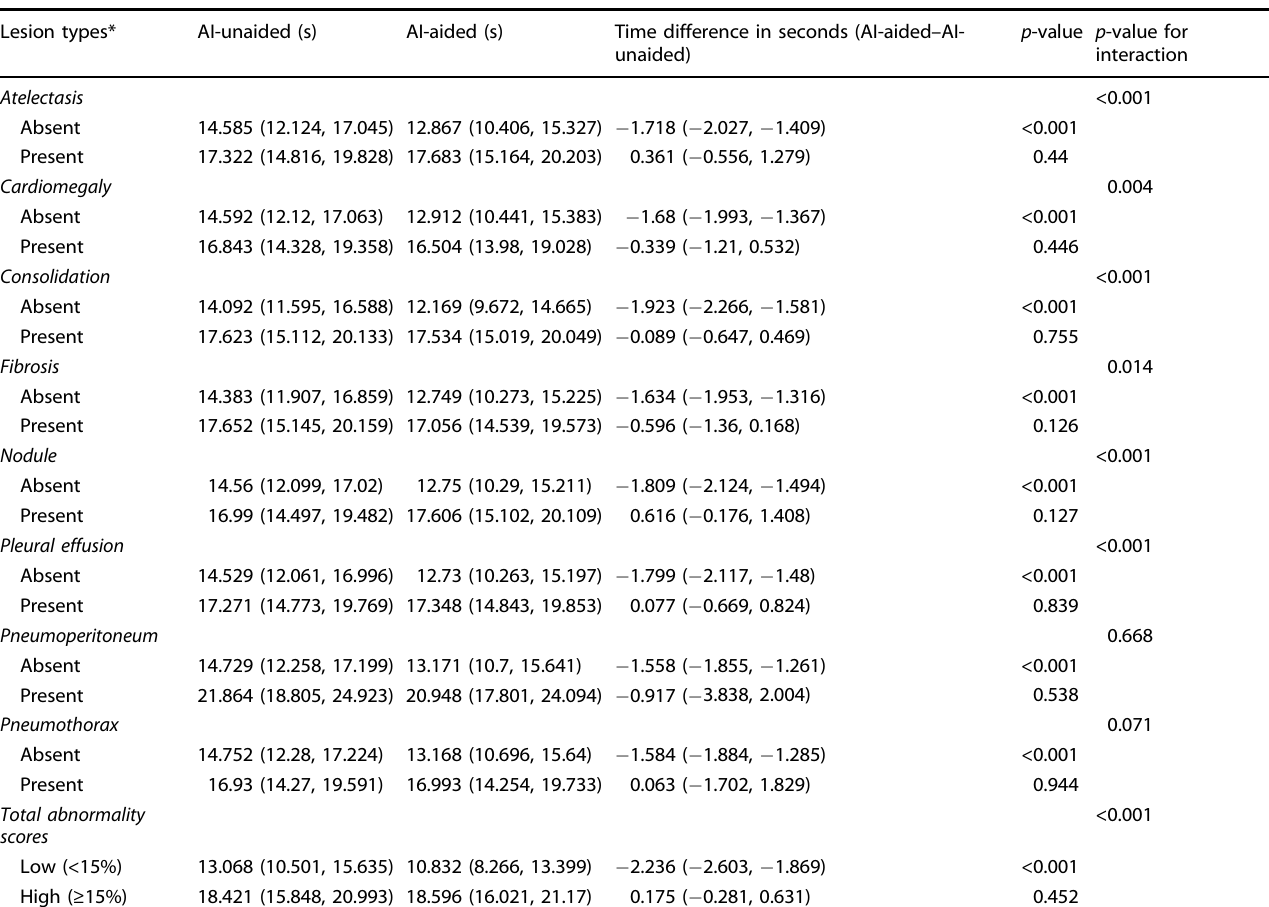
Table 3. Comparison of reading times according to the presence of lesions.